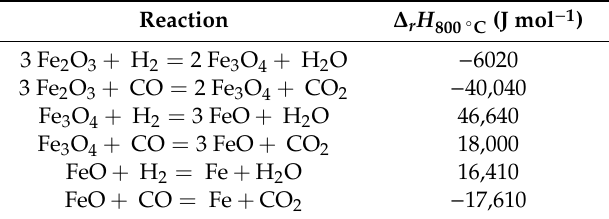
Table 4. Heat values of the reduction reactions. A minus sign indicates an exothermic reaction.